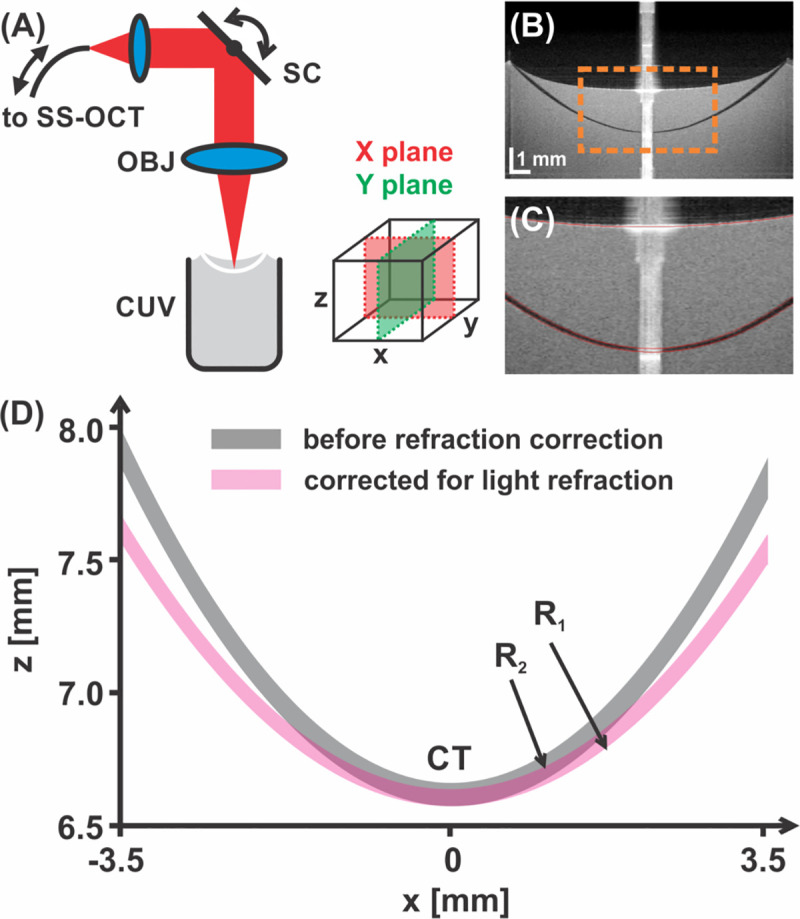
Experimental SS-OCT set-up for quantitative inspection of SCLs.SC, scanner; OBJ, objective; CUV, cuvette with the lens under investigation. (A) Central X and Y cross-section (plane) extracted from the three-dimensional data set. (B) Central cross-sectional image of the lens in the cuvette with enhanced contrast. (C) Segmentation of the intralipid solution interface and CL interfaces. (D) A refraction correction algorithm must be applied to the segmented surfaces to obtain geometrically accurate lens parameters. R1, anterior radius of curvature; R2, posterior radius of curvature; CT, central lens thickness.